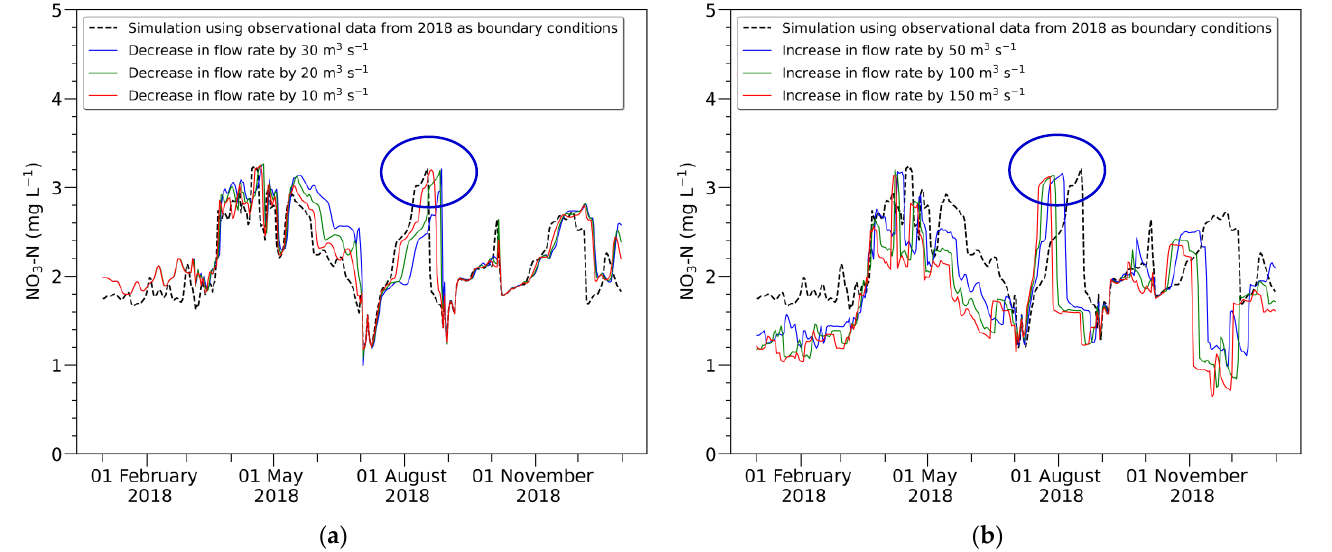
Figure 9. Changes in the NO 3 -N concentration in cross section 416 caused by variations in flow rate at the upstream boundary for 365 days. The black graph shows the NO 3 -N concentration simulated using the observational data from 2018 as boundary conditions. The dispersion coefficient was set to zero. ( a ) Changes in the NO 3 -N concentration by a decrease in flow rates (Scenarios 1 – 3); ( b ) changes in the NO 3 -N concentration by an increase in flow rates (Scenarios 4 – 6).